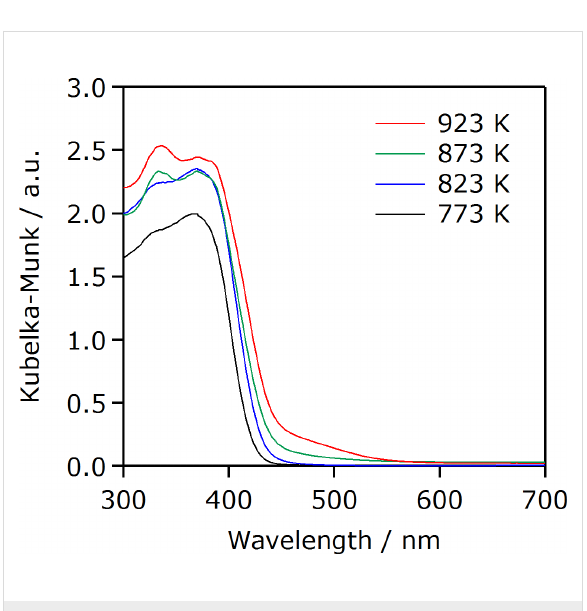
Figure 4: UV–visible diffuse reflectance spectra of g-C 3 N 4 synthesized at different